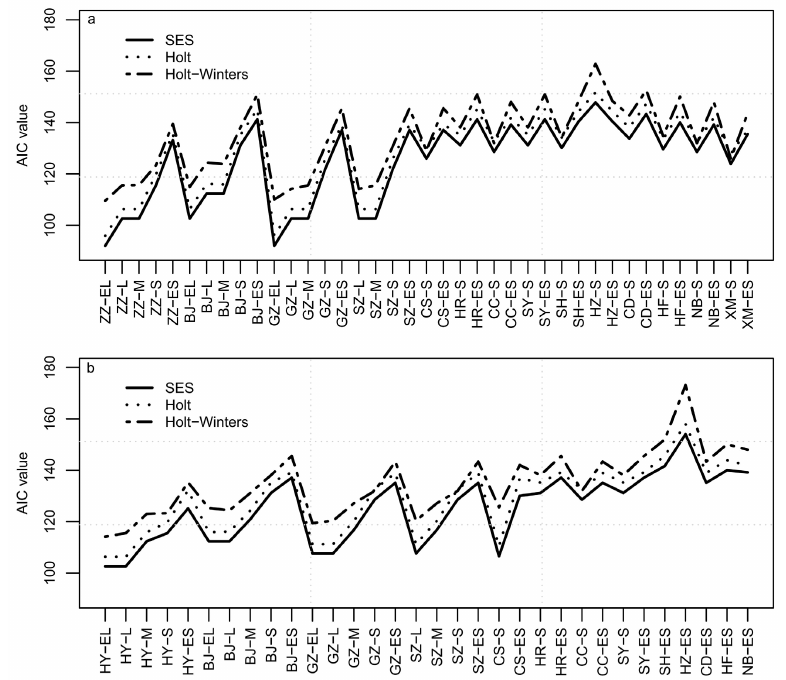
Figure 4. The AIC value for three models. ( a ) ZZ group; ( b ) HY group.